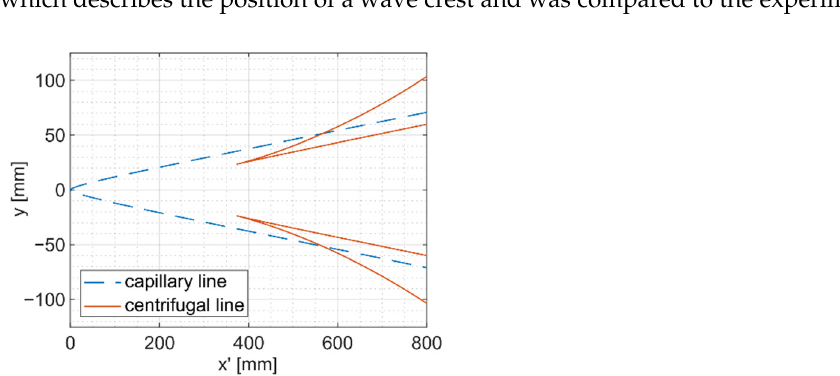
Figure 2. Solution of the Kelvin wake equations (1, 2) for n = 1 and u = 15 m/s in lithium. The blue dashed line (capillary line) represents the wake line dominated by surface tension. The red solid line (centrifugal line) is the wake line dominated by the centrifugal acceleration.